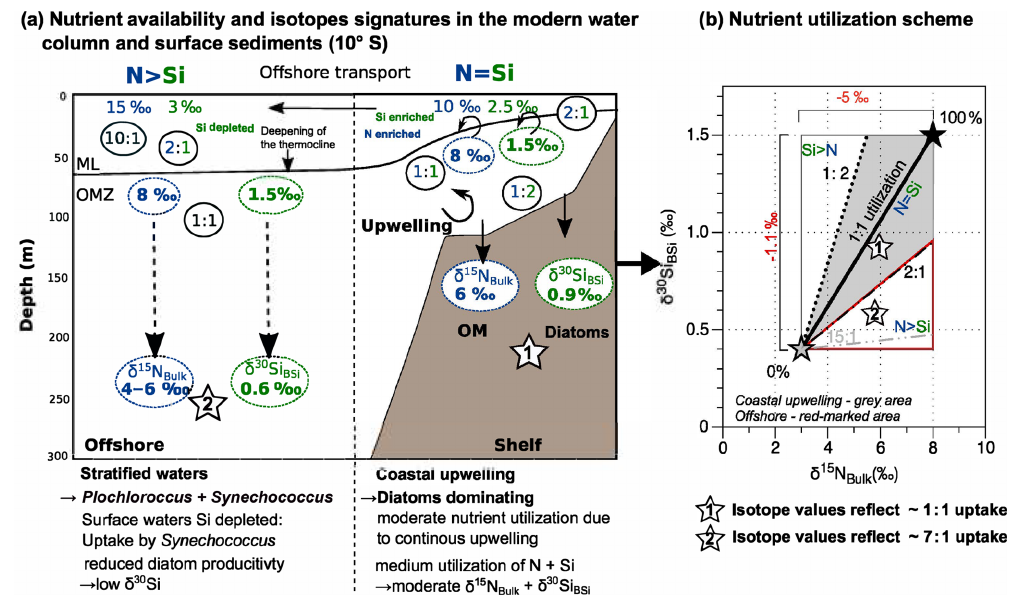
Figure 3. (a) Simplified schematic figure of the 10 ◦ S transect off the coast of Peru indicating the concentrations of Si ( OH ) 4 (green) and : Si ( OH ) : Si). The stable isotope composition in the water NO − (blue; given as enriched or depleted) together with the NO − 4 ratios (N 3 3 column given as δ 30 Si ( OH ) 4 and δ 15 NO − and the δ 30 Si BSi and δ 15 N Bulk signatures in underlying sediments. Diatoms are dominant on the 3 shelf, whereas non-siliceous organisms ( Synechococcus , Prochlorococcus ) dominate the offshore productivity (modified from Grasse et al., 2016). (b) Schematic overview of nutrient utilization: the black star marks the source signature (or 100% utilization) for δ 15 NO − (8‰) and 3 for δ 30 Si ( OH ) 4 (1.5‰) at the location, the grey star marks the theoretical isotopic compositions for ∼ 0% utilization, and the thick black solid line indicates the 1 : 1 utilization for N = Si. The δ 30 Si BSi and δ 15 N Bulk signatures from the shelf (white star 1) reflect an N:S uptake close to 1:1 while offshore signatures (white star 2) indicate higher N over Si utilization (N > Si). The rectangle indicates the total range of possible isotopic values. The respective fractionation factors are given in